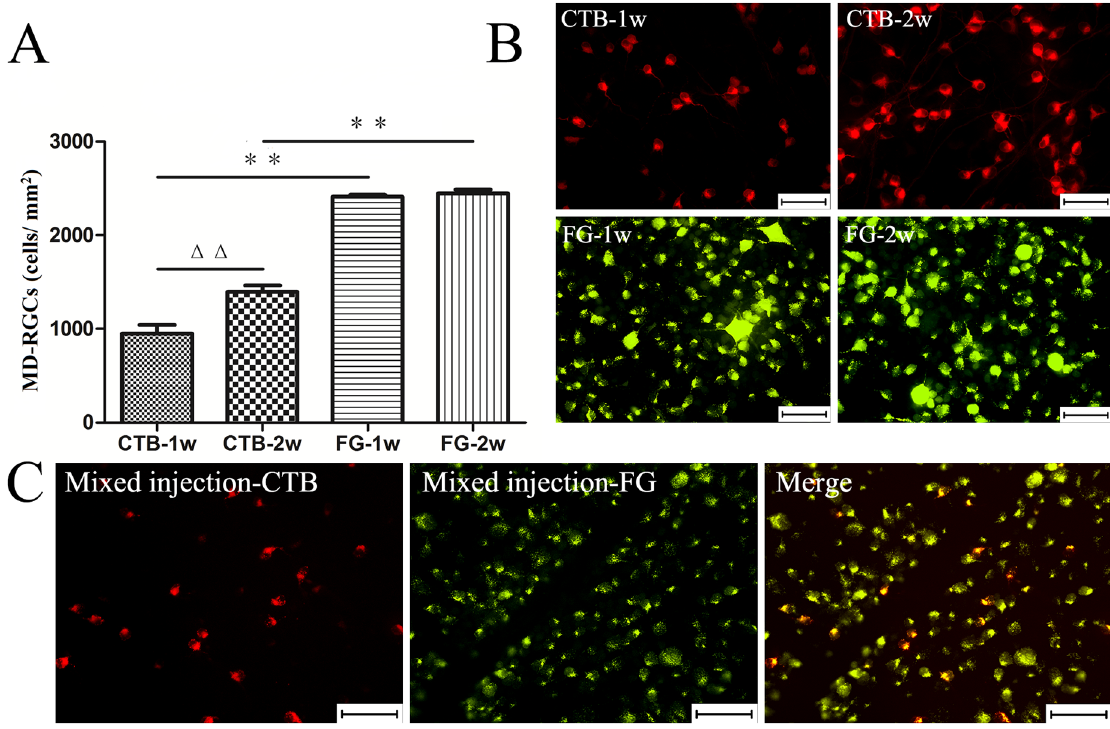
Fig 1. The mean density of retinal ganglion cells (MD-RGCs) retrograde labeled by cholera toxin subunit B (CTB) and Fluorogold(FG) at 1 week and 2 weeks in rats. (A) MD-RGCs in CTB-1w (rats euthanized 1 week post-CTB injection) and CTB-2w (rats euthanized 2 weeks post-CTB injection) were less than those in FG-1w (rats euthanized 1 week post-FG injection) and FG-2w (rats euthanized 2 weeks post-FG injection) (p < 0.001), MD-RGCs in CTB-2w was greater than that in CTB-1w (p < 0.001), but there was no distinction between the FG-1w and FG-2w (p = 0.982). (B) Representative photomicrographs taken at approximately 5/6 retinal radius in the superonasal quadrant showing retinal ganglion cells (RGCs) labeled by CTB and FG at 1week and 2 weeks. (C) In the rat euthanized 2 week post-mixed injection (CTB+FG), the number of FG-labeled RGCs far exceeded that of CTB-labeled RGCs in an identical visual field, the pictures were taken at approximately 1/2 retinal radius in the superotemporal quadrant. ΔΔ Two-way analysis of variance (ANOVA), p < 0.001; (cid:3)(cid:3) two-way ANOVA, p < 0.001. Scale bar = 50 μ